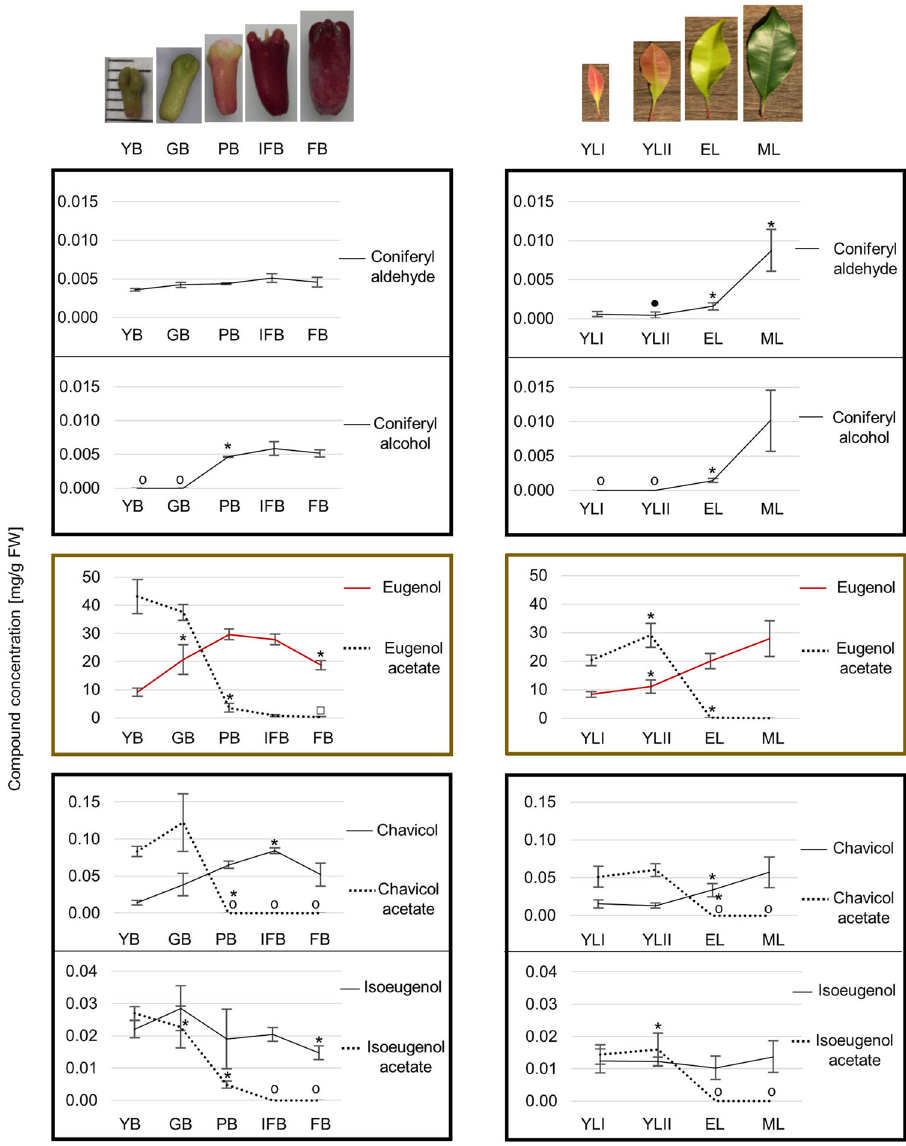
Fig. 5 Concentrations (mg/g FW) of the phenylpropenes eugenol, chavicol, and isoeugenol, their respective esters, and the precursors coniferyl aldehyde and coniferyl alcohol in Syzygium aromaticum leaves and buds among the growth phases. Data were represented as mean ± SD ( n = 3). Asterisks indicate signi fi cant concentration differences relative to the previous growth phase. Two-tailed t -test P < 0.05. □ Compound not detected in two of the three organ replicates; ● compound not detected in one of the three organ replicates; O compound not detected. Fresh weight (FW). Young buds (YB), green buds (GB), pink buds (PB), buds in the initial fruiting stage (IFB), buds in fruiting stage (FB), young leaves (YLI), expanded young leaves (YLII), expanded pale green leaves (EL), and mature leaves